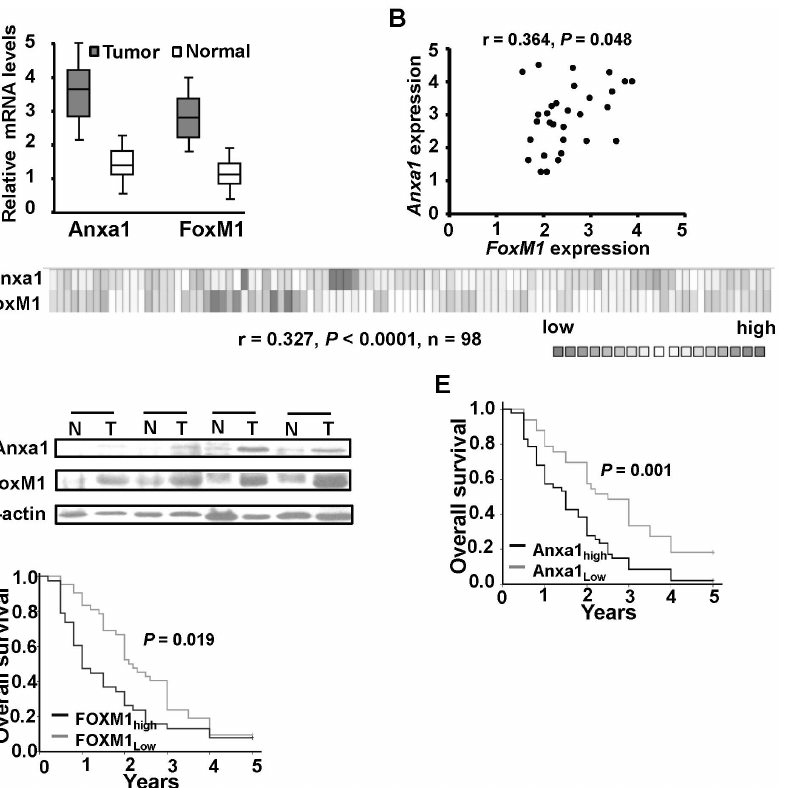
Figure 1. Expression of FoxM1 and Anxa1 in human normal brain and glioma tissues. A, Anxa1 and FoxM1 mRNA expression by RT-qPCR. The mRNA expression was analyzed in 30 matched primary glioblastoma tissues and the adjacent normal brain tissues. B, FoxM1 expression levels correlated positively with Anxa1 expression levels in glioblastoma samples (Pearson’s correlation test r=0.364; P =0.048). C, Headmay of a glioblastoma microarray data set from ONCOMINE data showing the expression levels of FoxM1 and Anxa1. The FoxM1 expression is correlated with Anxa1 expression (r=0.327, P , 0.0001). D, FoxM1 and Anxa1 protein expression levels in 4 matched primary glioblastoma tissues and the adjacent normal brain tissues by Western blot analysis. E and F, Kaplan-Meier estimates of overall survival time in patients who had a glioblastoma with different Anxa1 or FoxM1 expression.